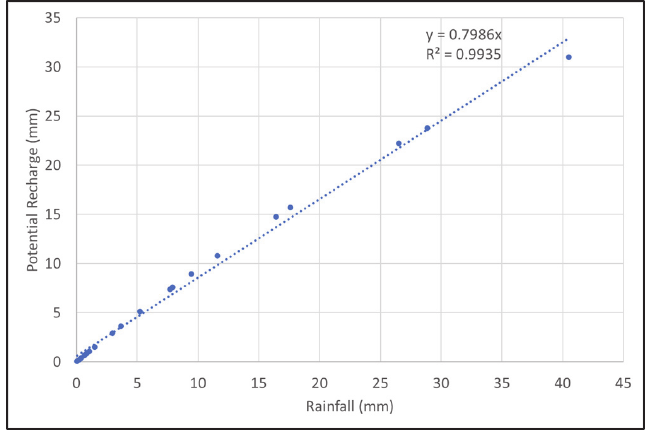
Figure 19. Graph of rainfall vs. potential recharge using CN 67.36 based on maximum daily rain ‐ fall on each month.